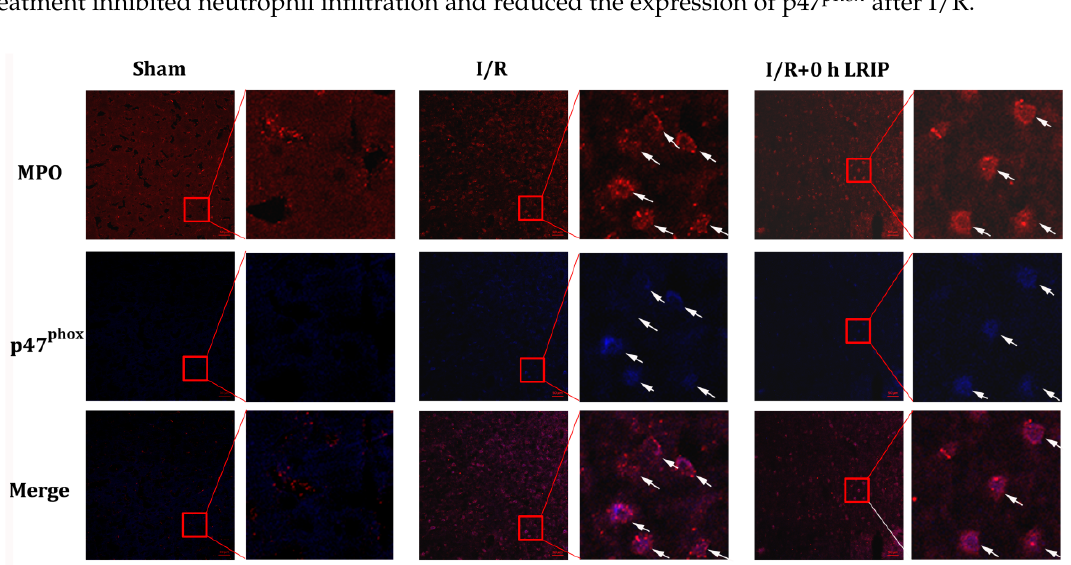
Figure 4. LRIP reduced the infiltration and p47phox membrane translocation of neutrophil. Representative immunofluorescence microscopeimages of p47 phox (blue) in neutrophils with the marker MPO (red). Scale bar = 50 µm in 200× images and 20 µm in 600× images. Infiltration of neutrophils was increased in the I/R group and the expression and membrane translocation of its p47 phox were augmented. These phenomena were attenuated in the I/R + 0 h LRIP group.